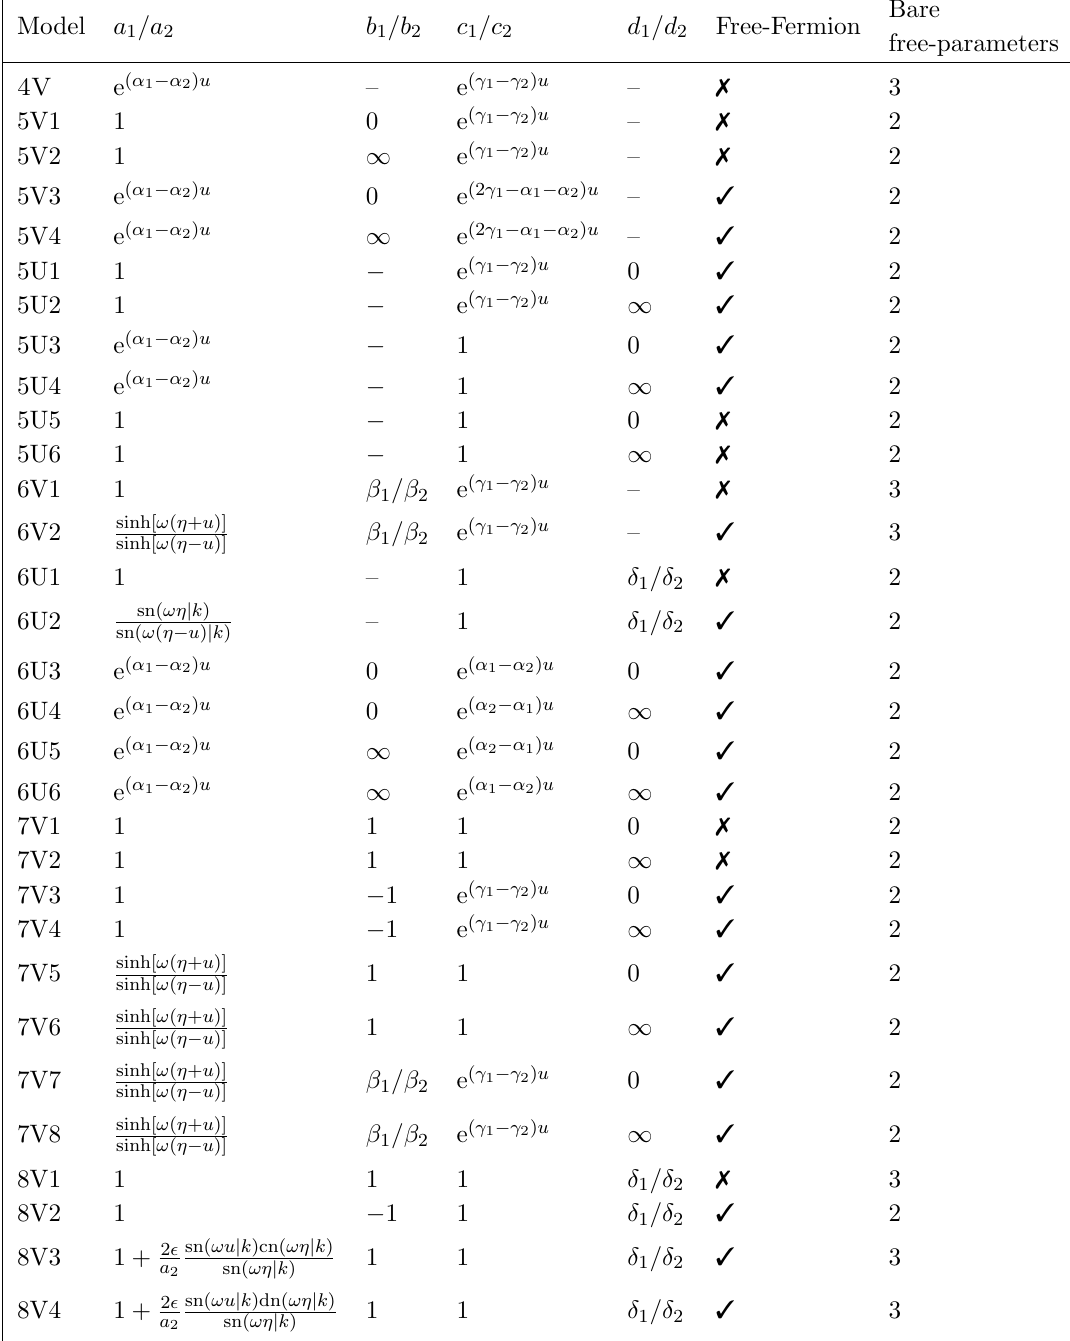
Table 1 . Classi(cid:12)cation of the solutions of the ybe for two-state systems according to the ratios of the R matrix elements. We also indicate whether or not the respective solution is of the free-fermion type (i.e., if the quantity (cid:8) = a 1 a 2 + b 1 b 2 (cid:0) c 1 c 2 (cid:0) d 1 d 2 is zero or not), and we give as well the number of bare free-parameters of the solutions. In total we found thirty-one families of solutions.